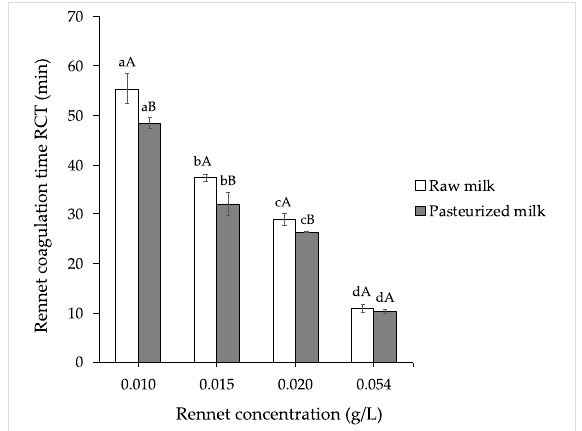
Figure 1. Influence of rennet concentration and heat treatment of milk on rennet coagulation time RCT (min). Values with different lowercase letters (a, b, c, d) represent differences between levels of rennet concentrations, different uppercase letters (A, B) represent differences between milk heat treatments (raw/pasteurized). Mean comparisons were performed with the Tukey HSD test ( p < 0.05).